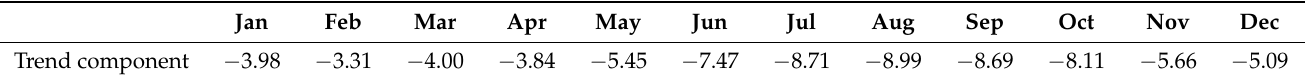
Figure 6. Prediction results of the lake’s surface area obtained from MLP model I. ( a ) Predictions for the lake’s surface area (km 2 ) and ( b ) Residual from the model.